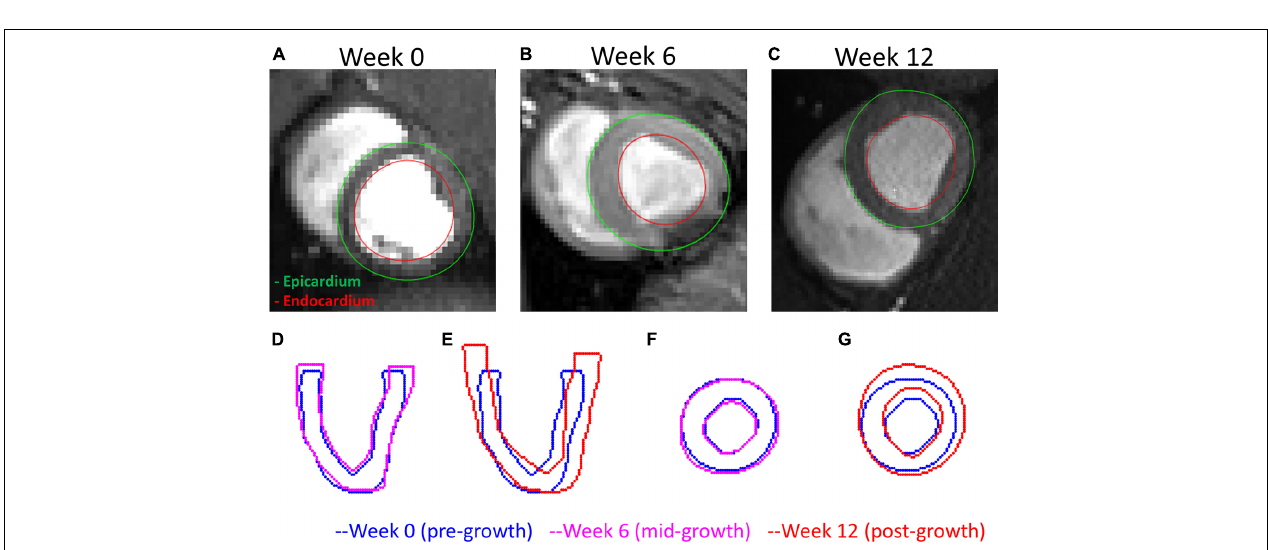
FIGURE 6 | Contour plots comparing the predicted and target LV geometry from the short axis and long axis views. The top row (A) includes the longitudinal growth examples ( α f = 0 . 9, α n = 0 . 3) and the bottom row (B) includes the transverse growth examples ( α f = 0 . 1, α n = 0 . 3).